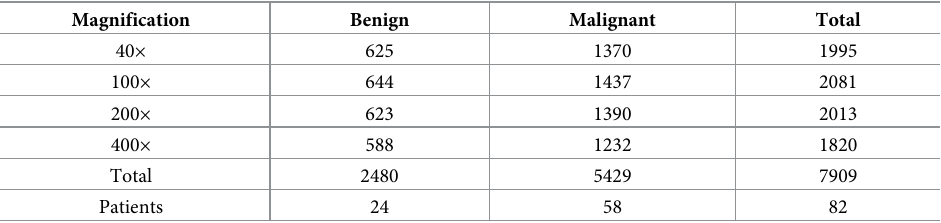
Table 1. Image distribution by magnifications and classes.